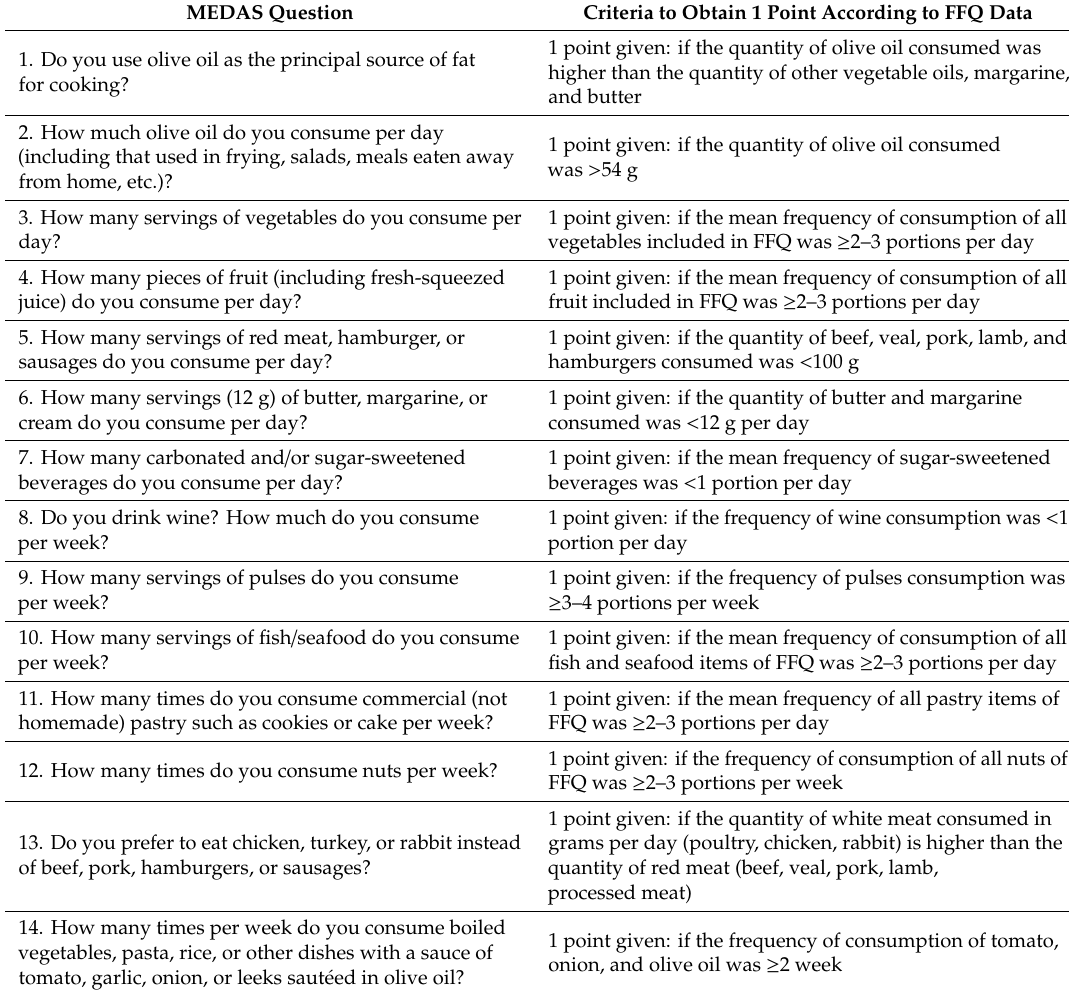
Table 1. MEDAS questions and criteria obtained from Food Frequency Questionnaire (FFQ)